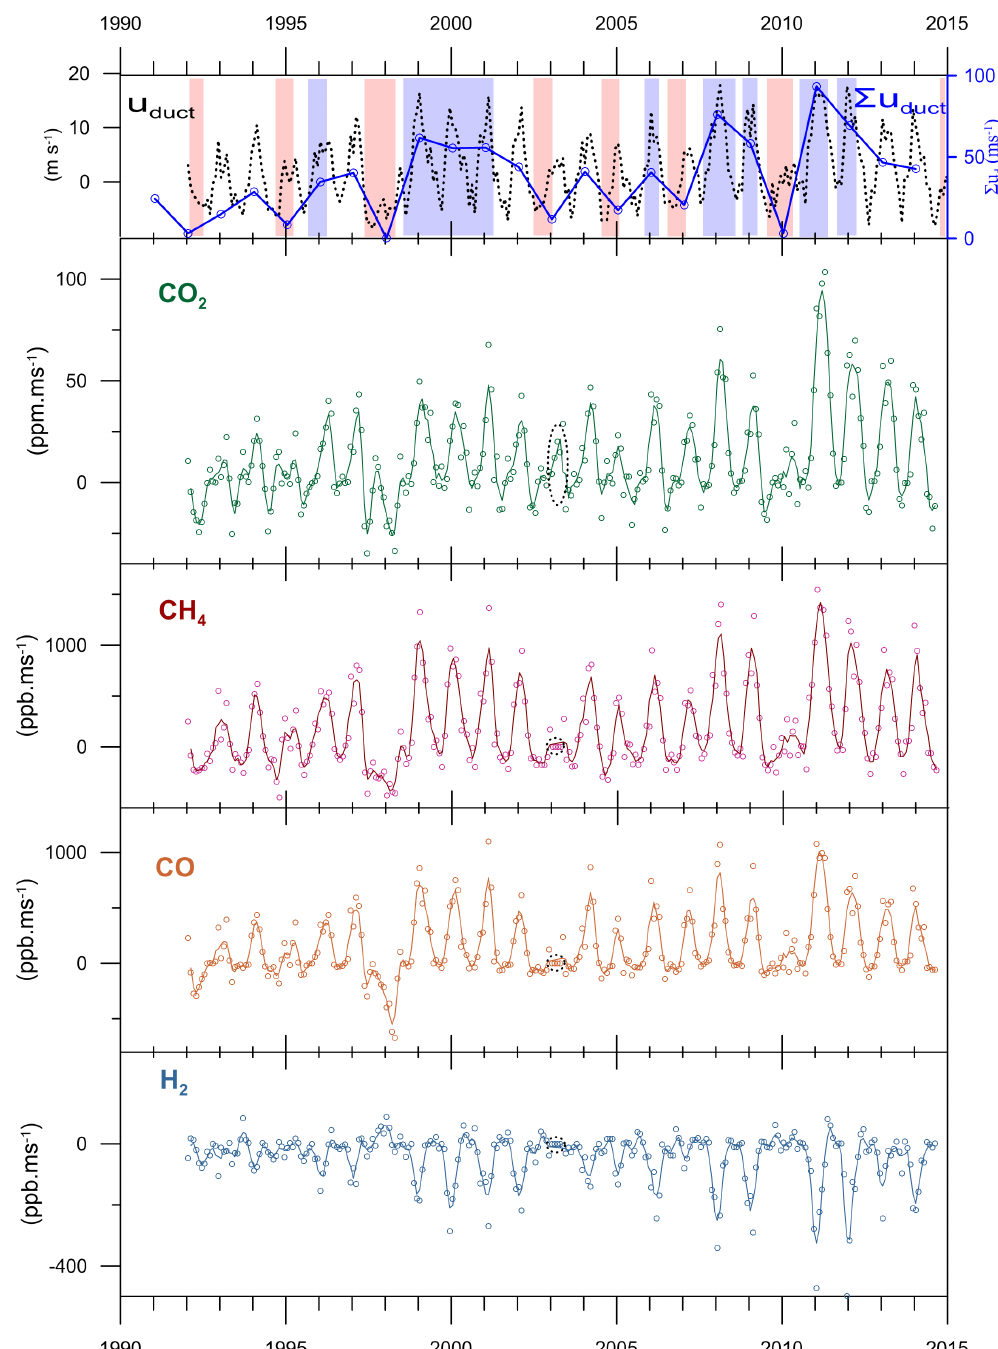
Figure 5. Monthly interhemispheric exchange for CSIRO trace gas species: the top panel shows monthly u duct (300hPa, 5 ◦ N to 5 ◦ S, 140 to 170 ◦ W), with red and blue bands indicating El Niño and La Niña periods respectively. The relative strength and duration of NH winter (October to April) IH mixing is estimated by (cid:54)u duct , plotted in January. The following panels show the relative interhemispheric exchange fluxes ( (cid:49) C × u duct ) , due to Pacific upper-level equatorial turbulence, for different CSIRO flask species (CO 2 , CH 4 , CO, and H 2 ) . Black circles indicate 4 months of missing CSIRO flask data from mlo; for CO 2 , data from these months are obtained from NOAA